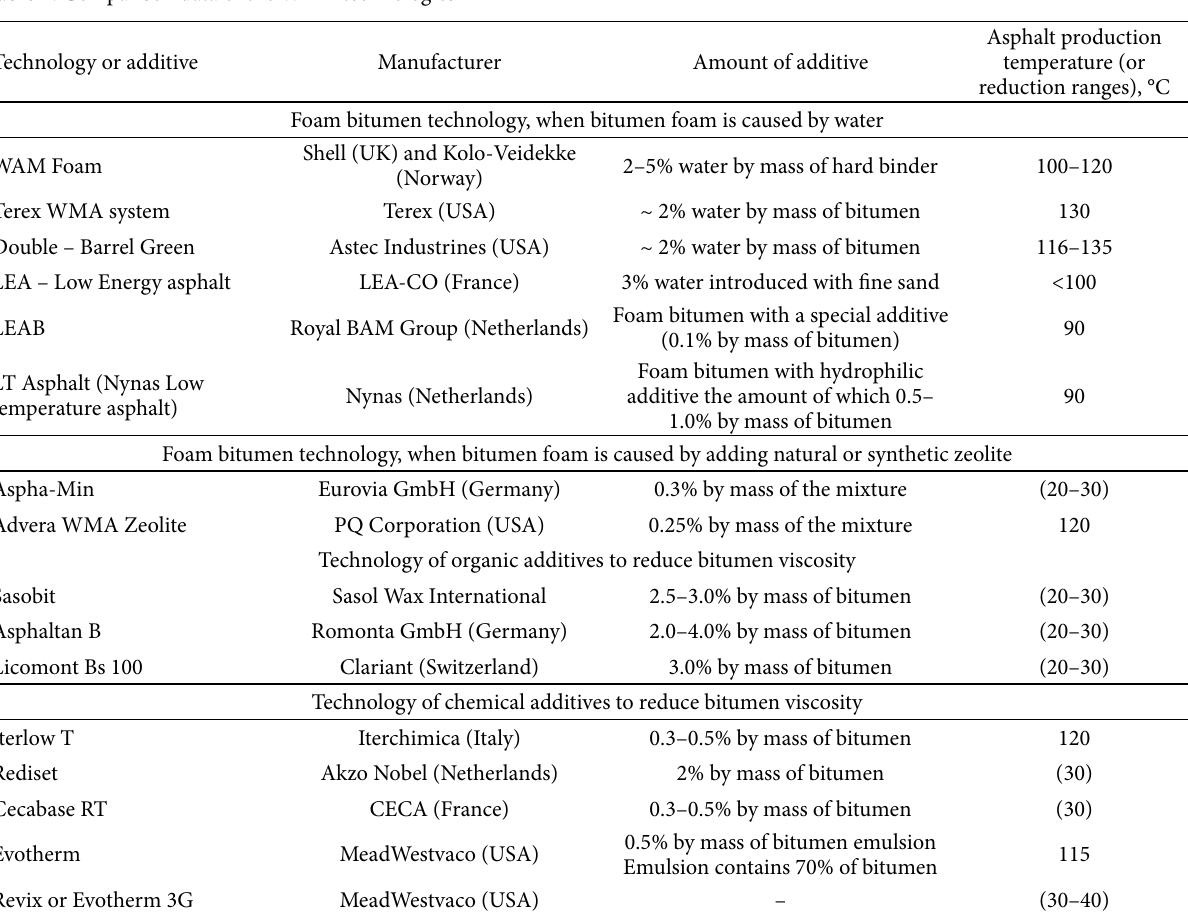
Table 1. Comparison data of the WMA technologies Technology or